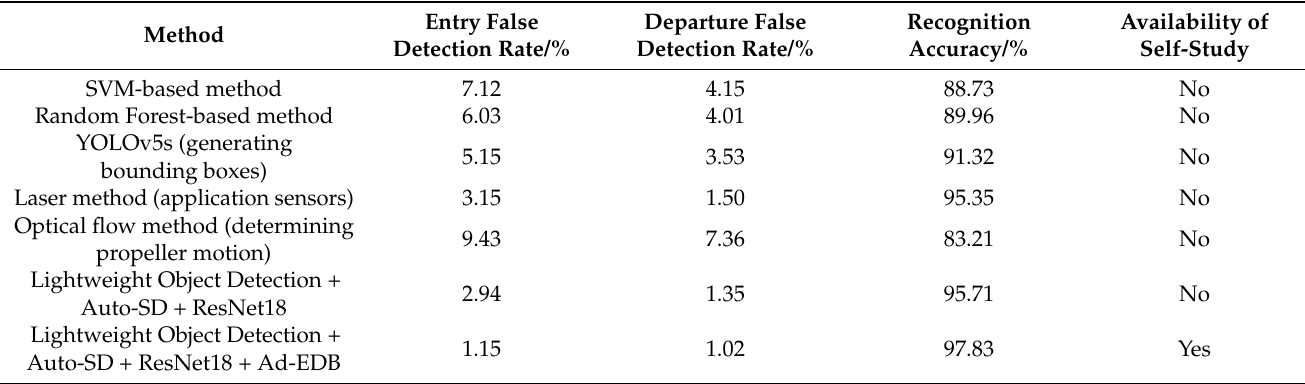
Table 3. Performance comparison of the overall